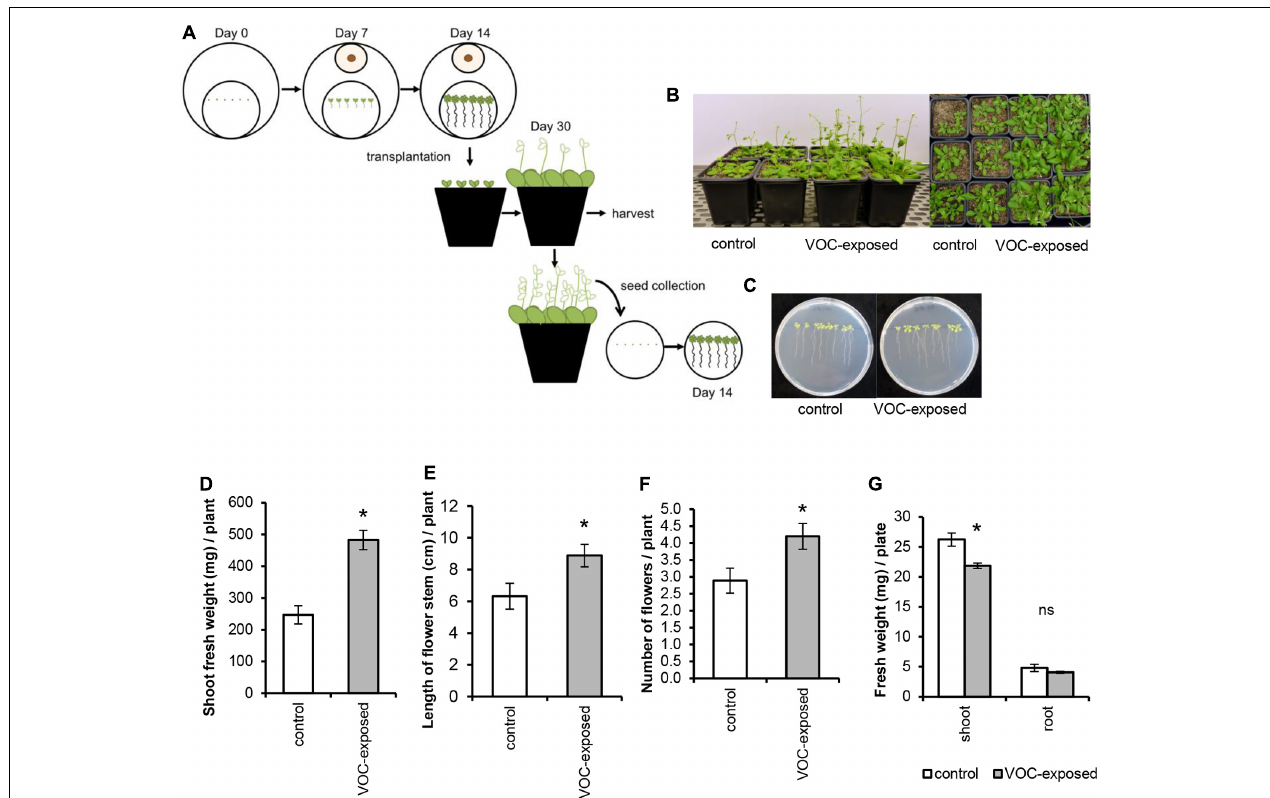
FIGURE 2 | Effects of short exposure of A. thaliana to volatile organic compounds (VOCs) produced by R. solani on plant growth and development. Plants exposed to fungal VOCs are referred as ‘VOC-exposed’ whereas plants exposed to agar medium are referred as ‘control.’ Asterisks indicate statistically significant differences based on pairwise comparisons between VOC-exposed and control plants (Student’s t -test, P < 0.05). Non-significant differences are displayed as ‘ns’. (A) Schematic representation of the experimental design. (B) Representative pictures of A. thaliana plants exposed for 1 week to fungal VOCs or not (control) that were transplanted into a soil-sand mixture and grown for 2 weeks in absence of the VOC-producing fungus. (C) Pictures of 14-day-old seedlings grown from seeds harvested from VOC-exposed plants. (D) Shoot biomass, (E) length of flower stem, and (F) number of flowers (mean ± SE, n = 12) of VOC-exposed and control plants. (G) Shoot and root biomass (mean ± SE, n = 4) of seedlings grown from seeds harvested from VOC-exposed plants. Each replicate consists of one Petri dish with eight